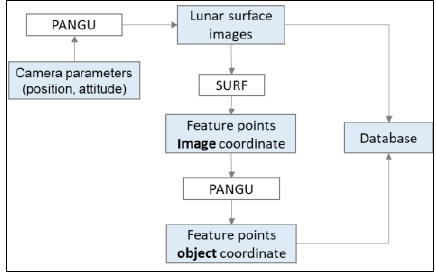
Figure 5. Database construction flowchart